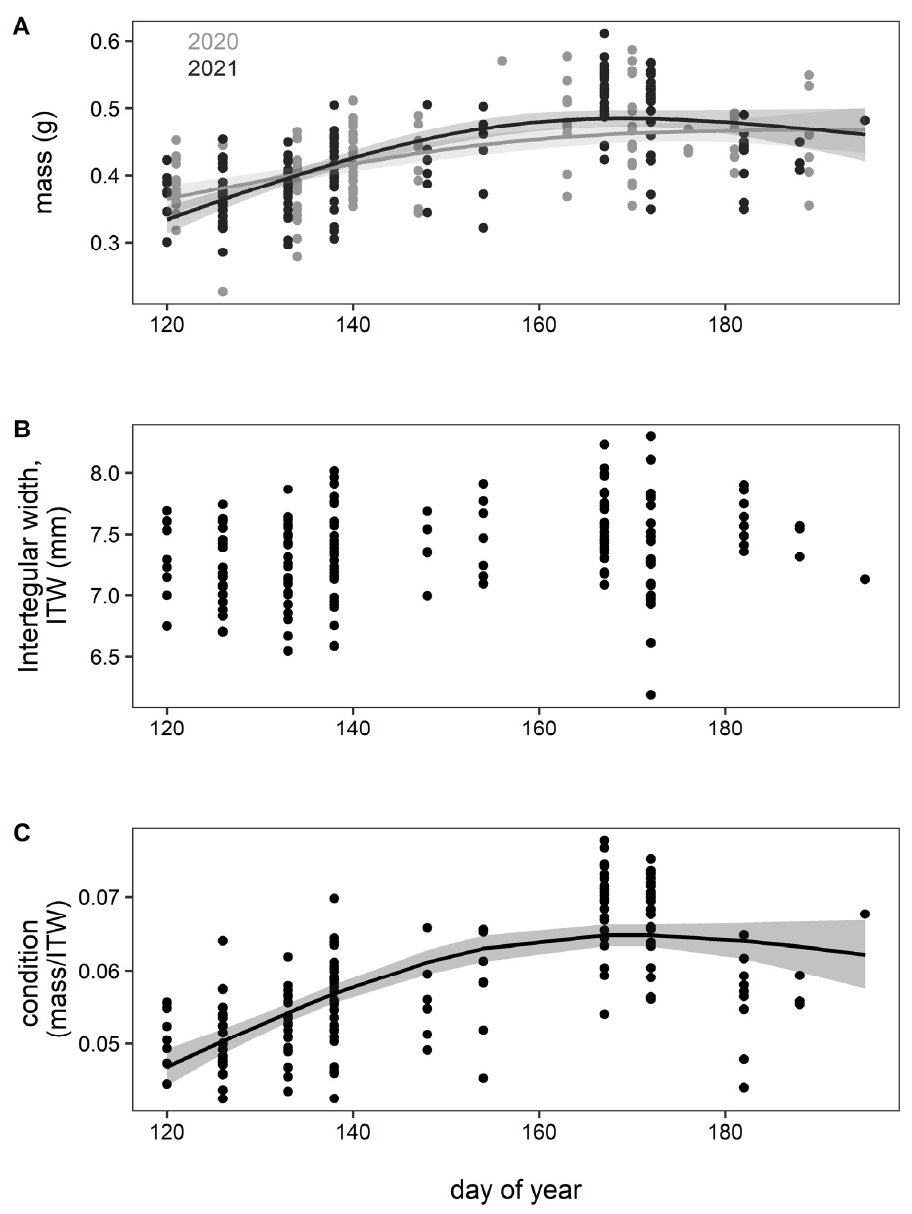
Figure 3. Mass and body condition varied with timing of queen emergence, while ITW did not. ( A ) Queen mass increased significantly with day of emergence for both 2020 (gray points and lines; n = 130) and 2021 (black points and lines; n = 165) (GAM, R 2 = 0.397, df = 6.770; n = 295; Table 1); ( B ) ITW did not change significantly with day of year (GAM, R 2 = 0.0794, df = 3.448, n = 165; Table 1); ( C ) Body condition (as estimated by the ratio of mass to ITW) increased strikingly with day of queen emergence early in the season, with day of emergence explaining over 45% of the variation in body condition (GAM, R 2 = 0.456, df = 3.958, n = 165; Table 1). After categorizing queen body condition as heavier or lighter than expected based on the regression estimate (Figure 2), emergence timing was strongly associated with rel- ative body condition for queen bees. The first emergence peak was dominated by queens